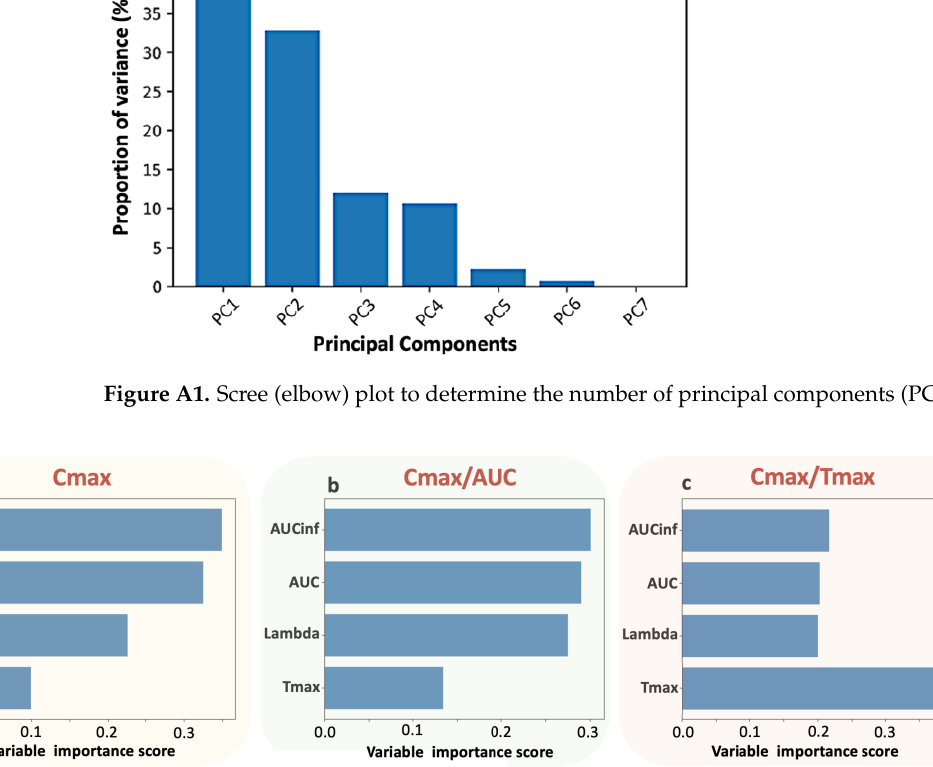
Figure A2 . Variable importance scores for the feature parameters (AUC, AUCinf, lambda, Tmax) of the pharmacokinetic parameters in the case of the actual bioequivalence study. Three random forest models were developed each one referring to Cmax ( a ), Cmax/AUC ( b ), and Cmax/Tmax ( c ).